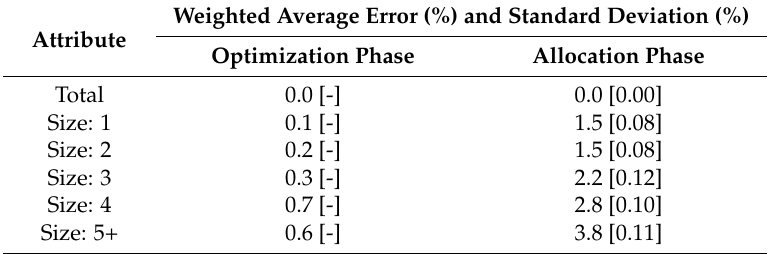
Table 2. Weighted average error and standard deviation for household attributes.